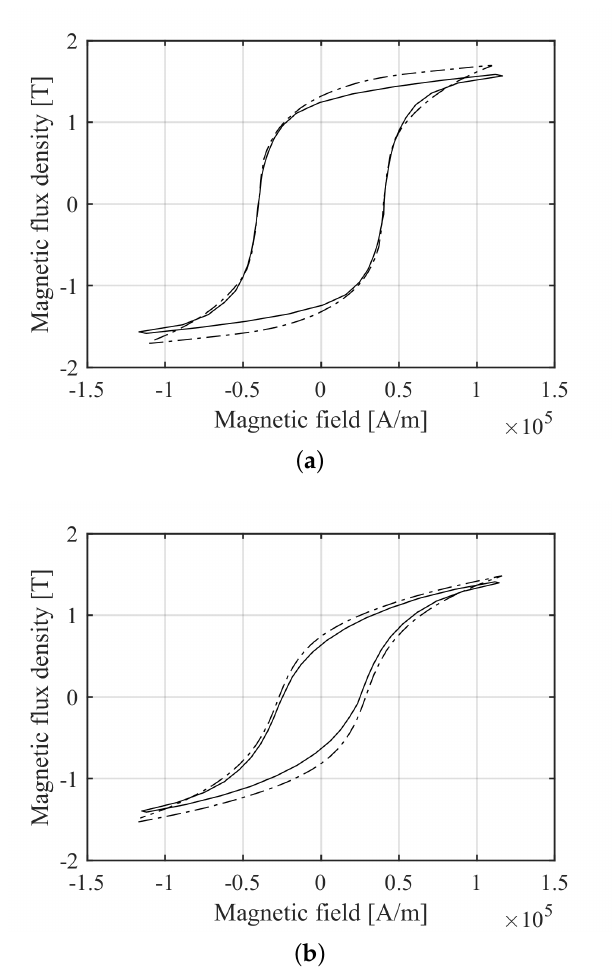
Figure 3. Radial ( a ) and tangential ( b ) magnetic characteristics of the FeCrCo 48/5 alloy: experimental (solid); numerical